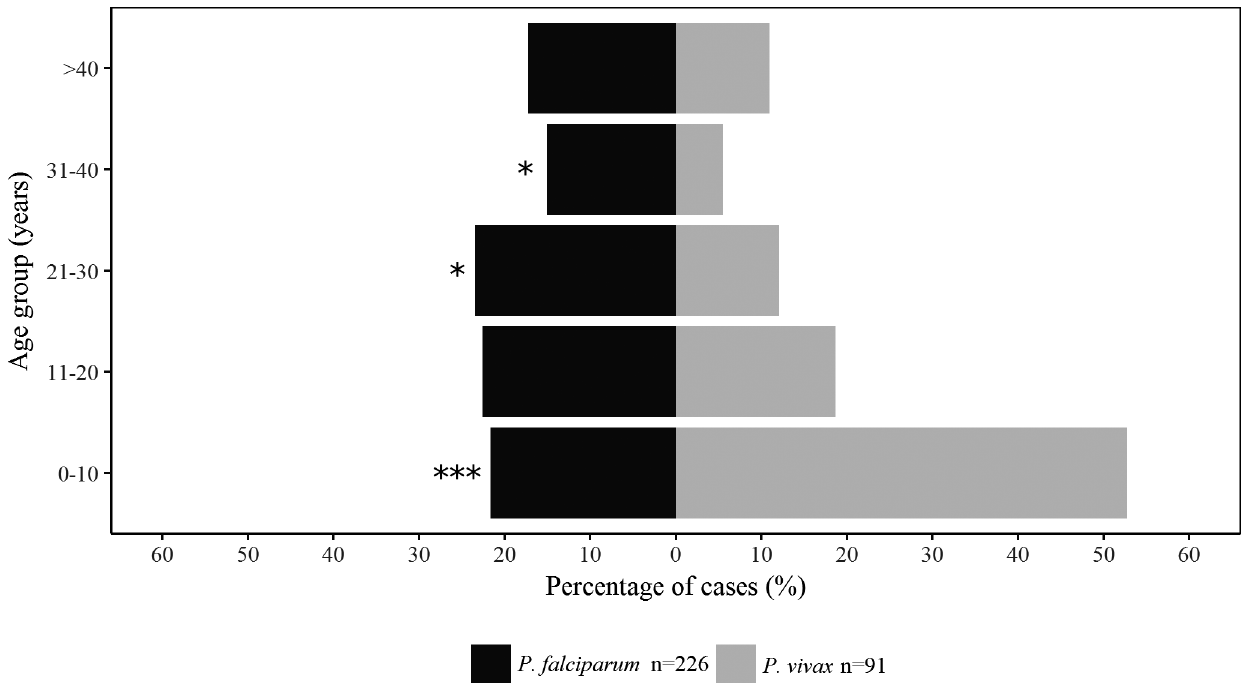
Fig 2. Prevalence and parasite species distribution according to age. Percentageof individuals infected with either P . falciparum or P . vivax parasitesstratified by age group. Statistical differencesbetween P . falciparum and P . vivax infectionswere calculatedusing the Chi- square test. * p value < 0.05, ** p value < 0.01, *** p value < 0.001.